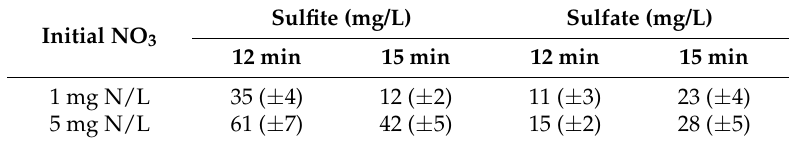
Table 1. The concentrations of sulfite and sulfate at 12 and 15 min of